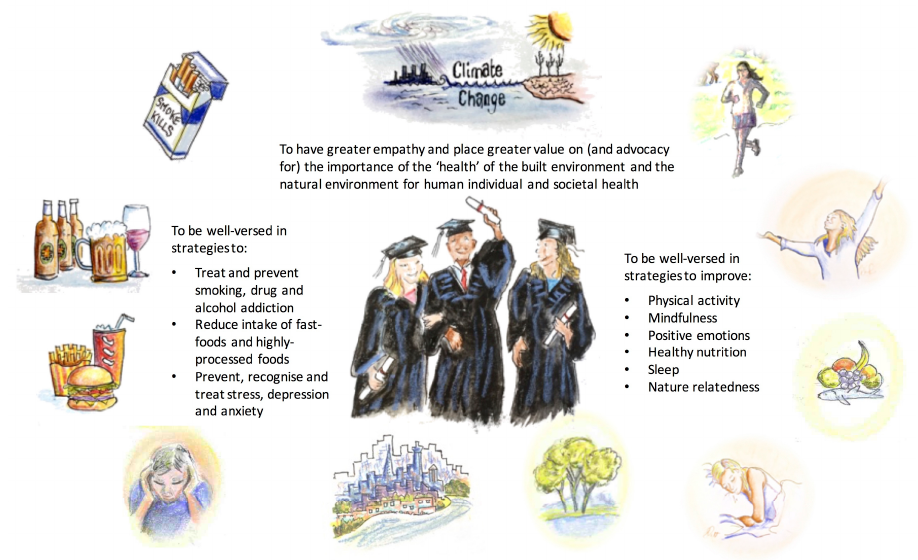
Figure 6. The future of human and societal health will depend on improved training and empathy